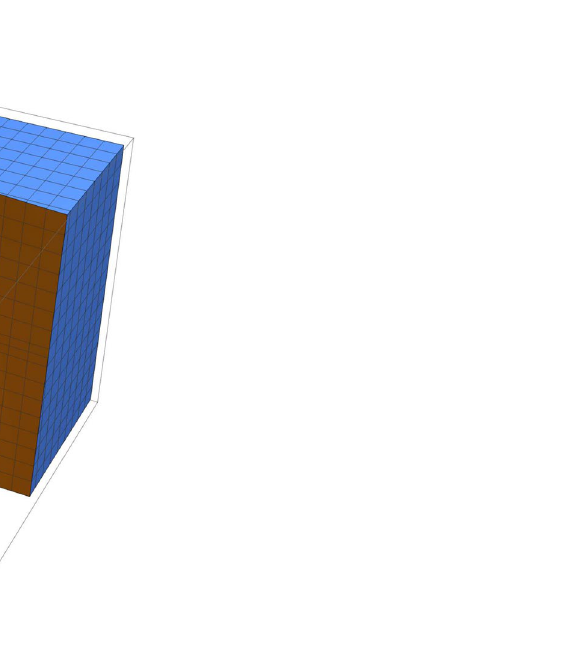
Figure 10. The time evolution of ρ eff 1 . C 2 =